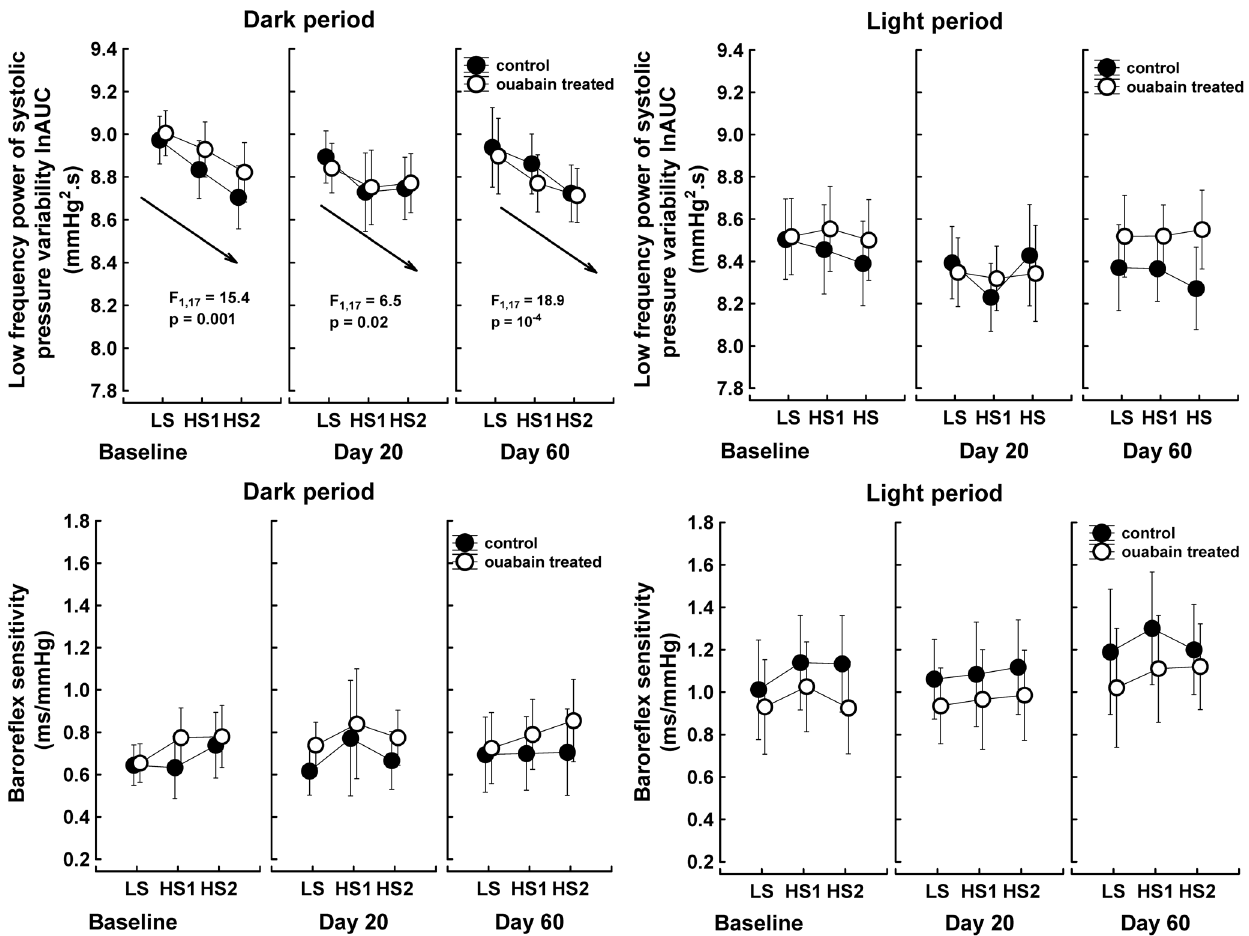
Figure 5. Low-frequency power of the systolic pressure variability and baroreflex sensitivity response to increased NaCl intake. The baroreflex sensitivity was estimated as the square root of the ratio of RR-interval and systolic pressure powers calculated over those frequency ranges where the coherence was . 0.5 and the phase angle , 0. The data points represent the means of two 35-min intervals selected in the middle of the dark and light periods; the vertical bars denote 95% confidence intervals, n=9 control rats; n=10 ouabain-treated rats. LS, low salt intake; HS1, 1 st day of high salt intake; HS2, 2 nd day of high salt intake. Baseline, salt test performed before the implantation of the ouabain pellets; Day 20, rats were treated for 27–29 days with 63 m g ouabain/kg/day; Day 60, rats were treated for 40 days with 63 m g ouabain/kg/day and then for 27–29 days with 324 m g ouabain/kg/day. Data were analyzed with repeated measures MANOVA and the multivariate Wilk’s test in a 2 (group) x 3 (time/ouabain treatment) x 3 (salt intake) x 2 (illumination) between-within design. Arrows denote the linear trend analysis common for both groups. F, univariate F- test value, subscripts are the degrees of freedom; P trend , probability that a linear relationship between time and analyzed parameters is due to chance.